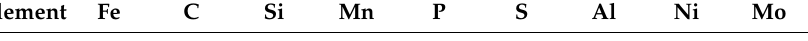
Table 1. Chemical composition of the investigated Fe-23Mn-0.3C-1Al high manganese steel. Element Fe C Si Mn P S Al Ni Mo Cr